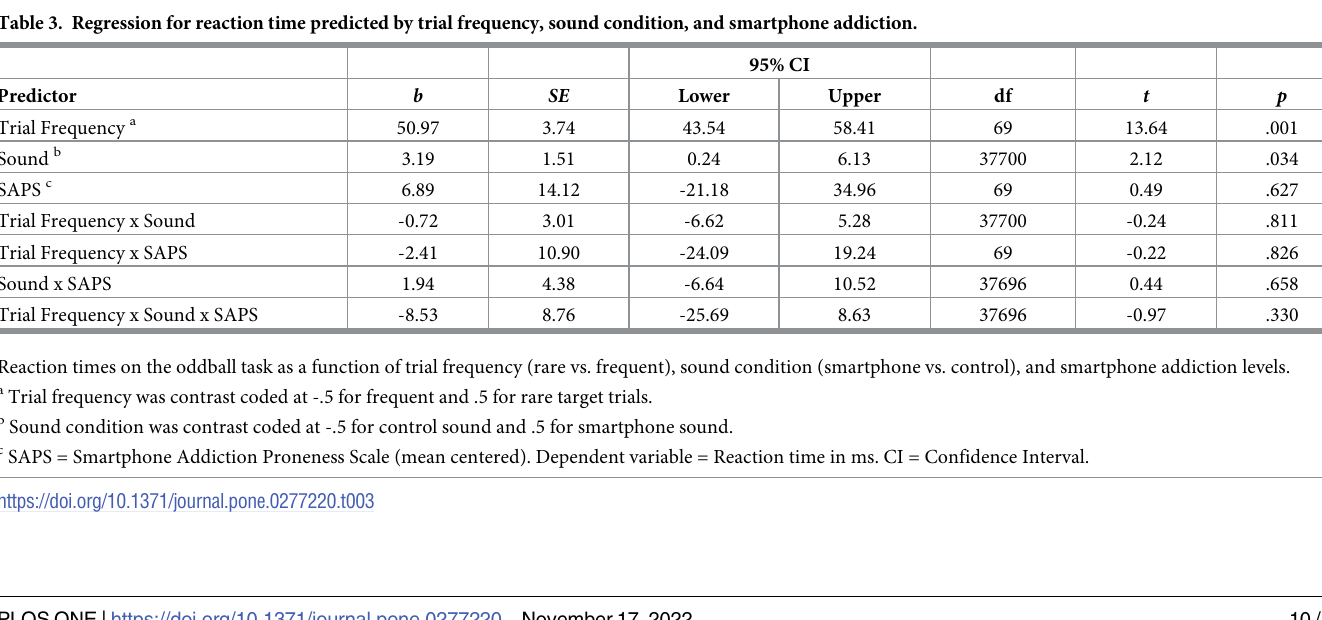
Table 3. Regression for reaction time predicted by trial frequency, sound condition, and smartphone addiction.